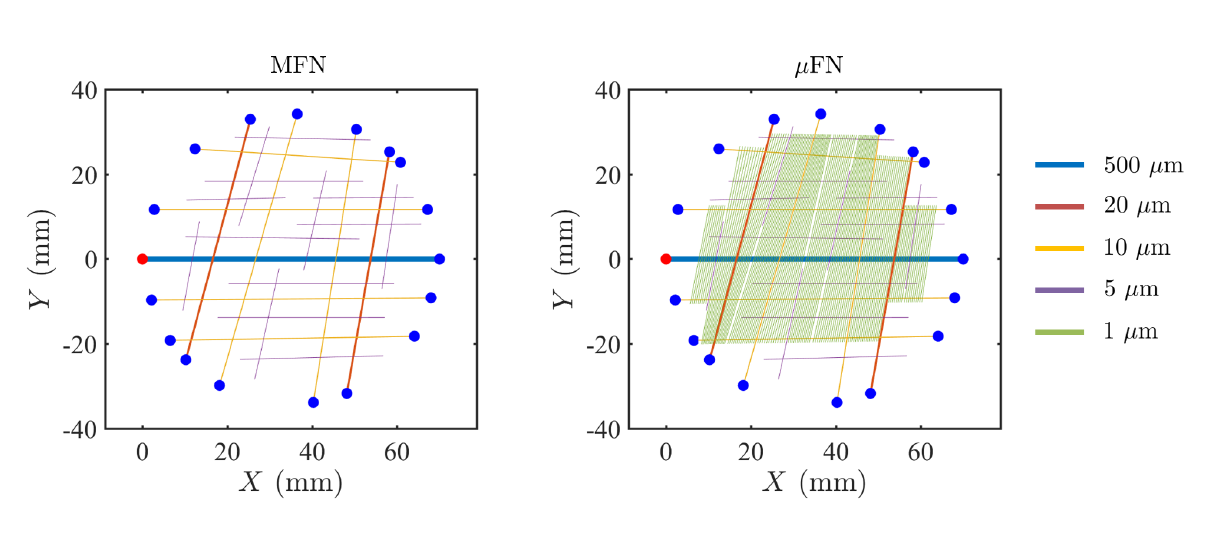
Figure 1. Scaling relationship between fracture aperture ( b ) and frequency ( f ). Marcellus shale experimental data is reproduced from [14].